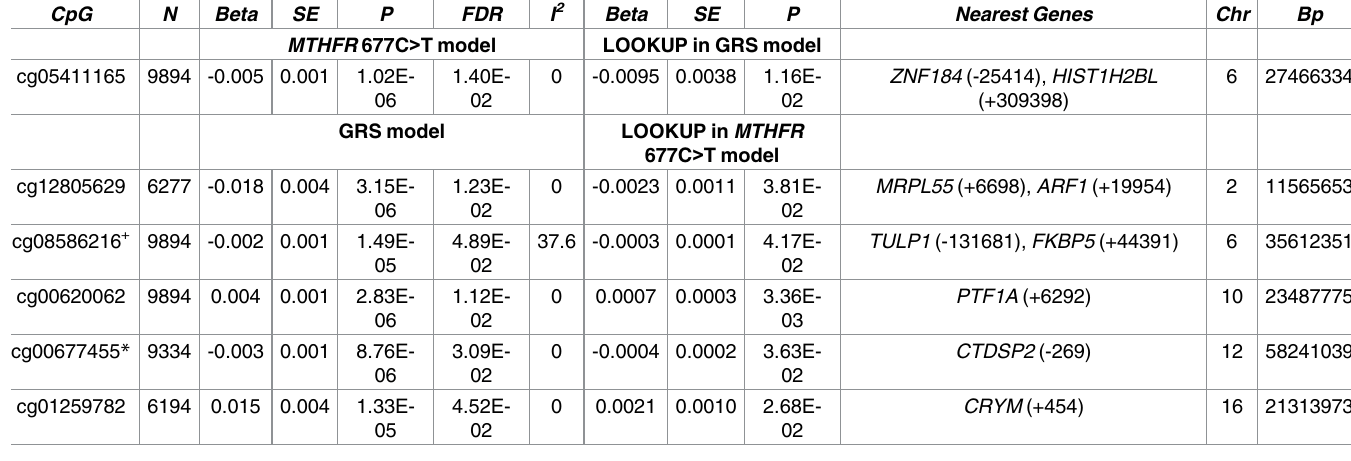
Table 2. Genome-wide trans -CpGs with FDR < 0.05;associated with the MTHFR 677C > Tmodel or Genetic Risk Score of 18 Hcy-associated variants. CpG N